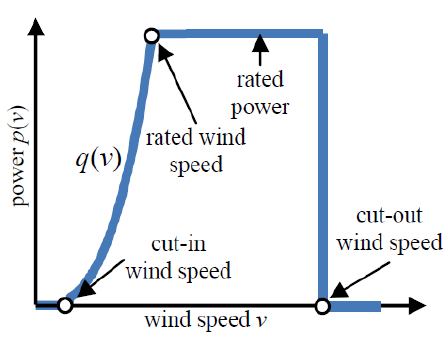
Figure 2 . Wind power